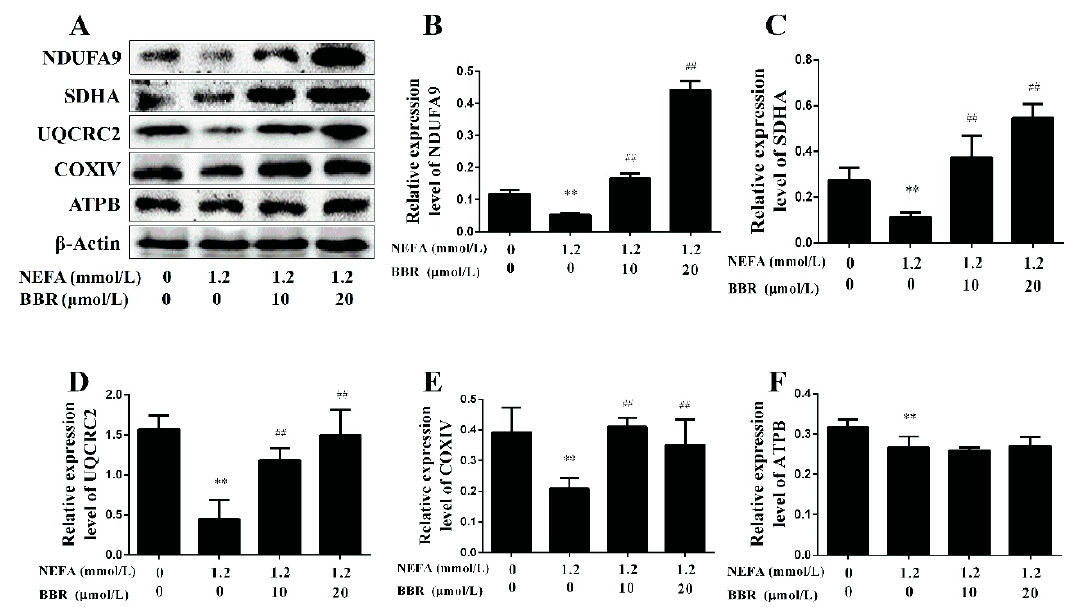
Figure 5. BBR improved the NEFA-induced mitochondrial respiratory chain function damage in bovine hepatocytes. Hepatocytes were assigned to four groups as follows: A control group, a 1.2 mmol/L NEFA treatment group, a 1.2 mmol/L NEFA and 10 µ mol/L BBR treatment group, a 1.2 mmol/L NEFA and 20 µ mol/L BBR treatment group. ( A – F ) Western blot analysis and quantification of five representative subunits of OXPHOS complexes, β -Actin served as an internal control. Quantified data are mean ± SD; ** p < 0.01 versus control group; ## p < 0.01 versus NEFA group.